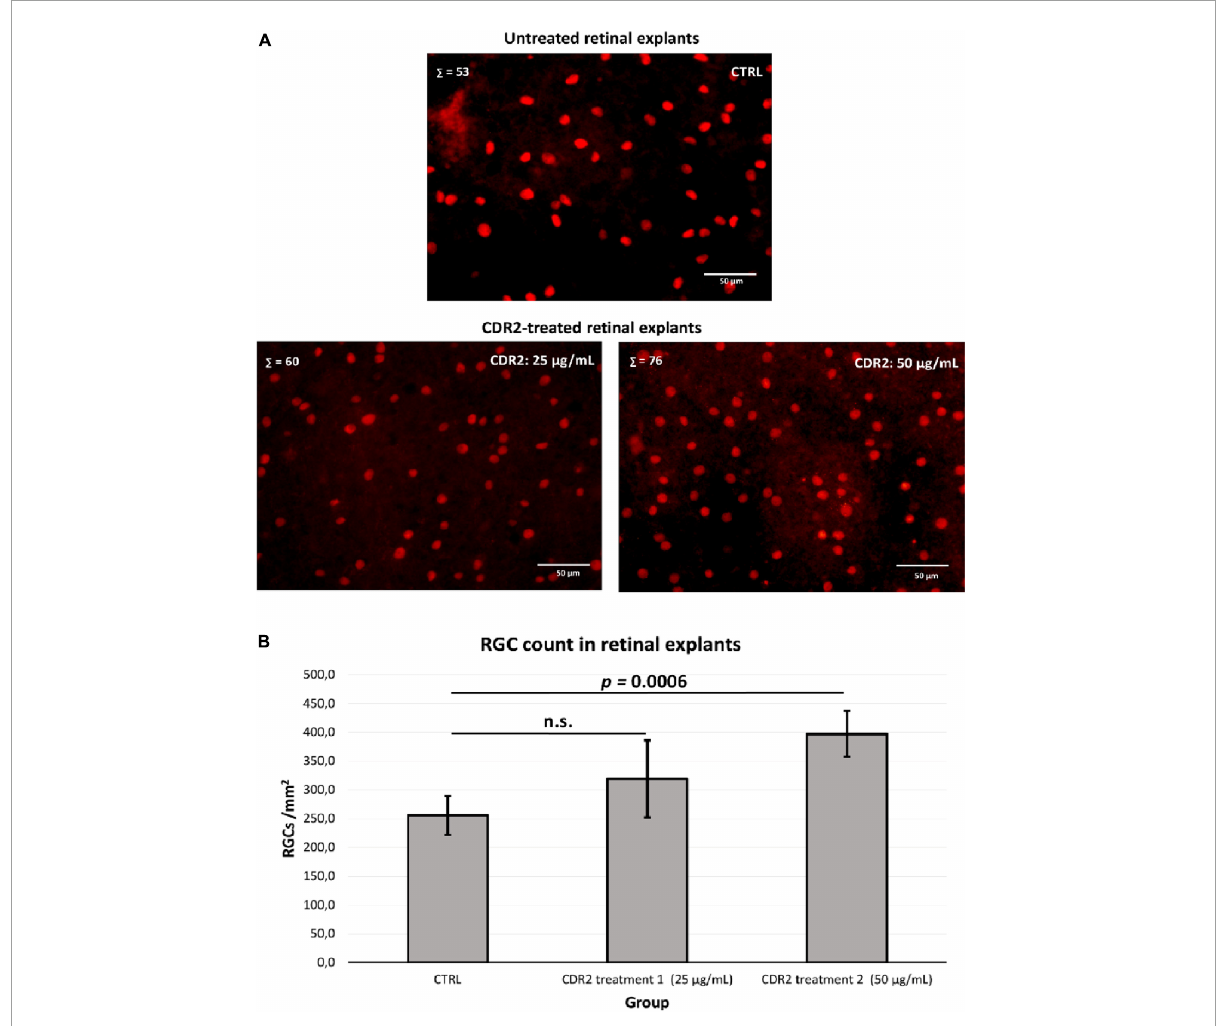
FIGURE3 Evaluation of the neuroprotective effects of the synthetic complementary-determining region 2 (CDR2) peptide (INSDGSSTSYADSVK) on the viability of retinal ganglion cells (RGCs) in the retina organ culture model in vitro . (A) The retinal explants ( n = 5 per group) were treated with either 25 or 50 µ g/mL CDR2 peptide or remained untreated as control group. The Brn3a + immunostaining was performed for the microscopic detection of RGCs. (cid:54) represents the number of Brn3a + RGCs in each picture. (B) The quantitative analysis of Brn3a + cells (RGCs) showed no significant difference between the retinal explants treated with 25 µ g/mL of synthetic CDR2 compared to control group ( p > 0.05). Ascending the concentration of synthetic CDR2 to 50 µ g/mL induced a significant higher survival rate of Brn3a + RGCs in the CDR2-treated retinal explants compared to the respective control explants ( p =